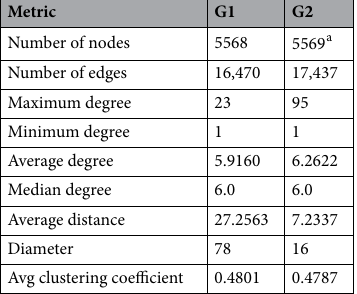
Table 1. Network metrics.